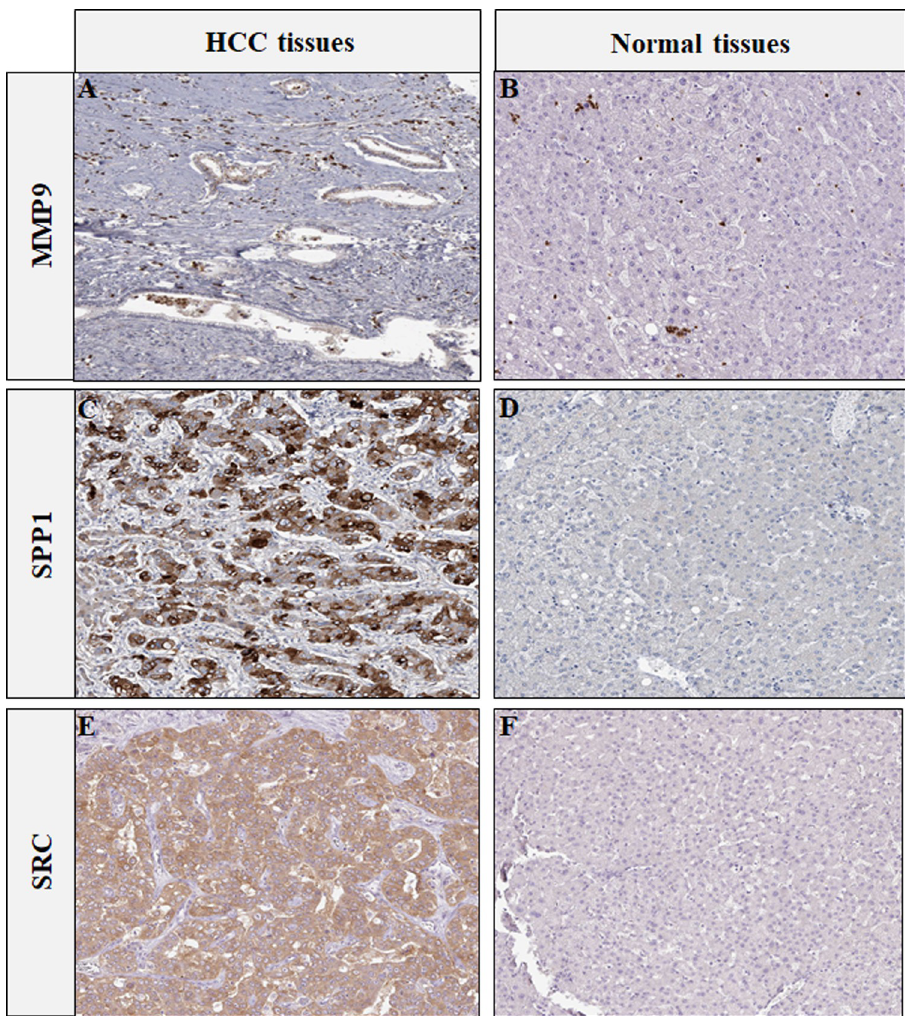
Fig 6. Immunohistochemistry of three hub proteins from the Human Protein Atlas database. Protein levels of (A) MMP9 in HCC tissues; (B) MMP9 in normal liver tissues; (C) SPP1 in HCC tissues; (D) SPP1 in normal liver tissues; (E) SRC in HCC tissues; (F) SRC in normal liver